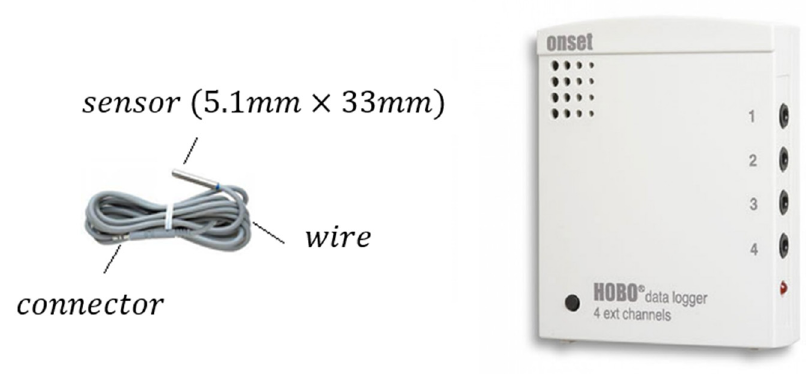
Figure 6. TMCx-HD sensor and HOBO data logger [58,59].